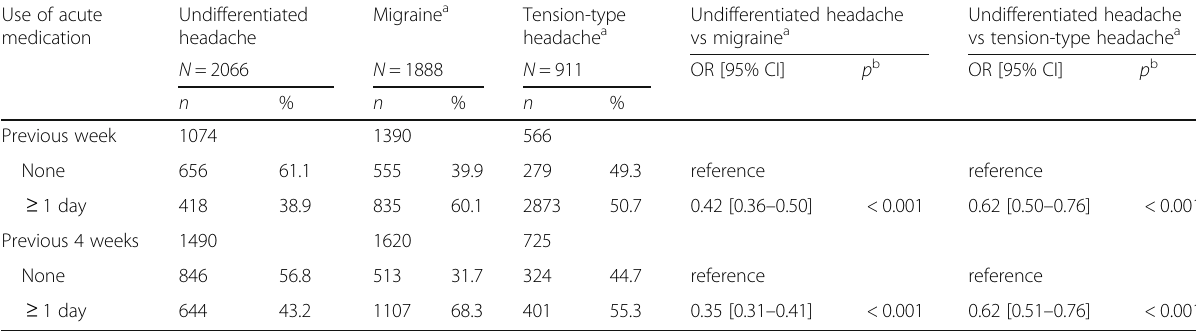
Table 4 Use of acute medication in undifferentiated headache, migraine and tension-type headache Use of acute